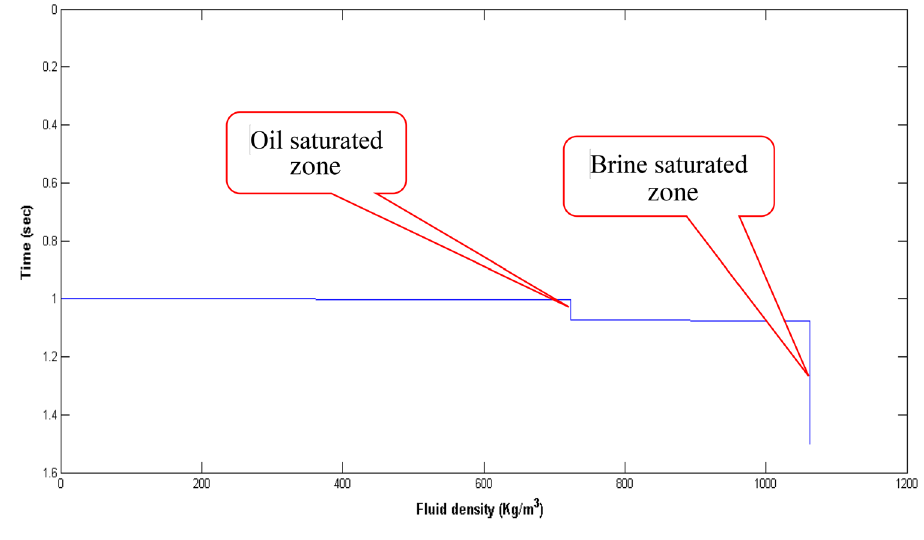
Fig. 12 Fluid velocity plot with 10% porosity of Arab